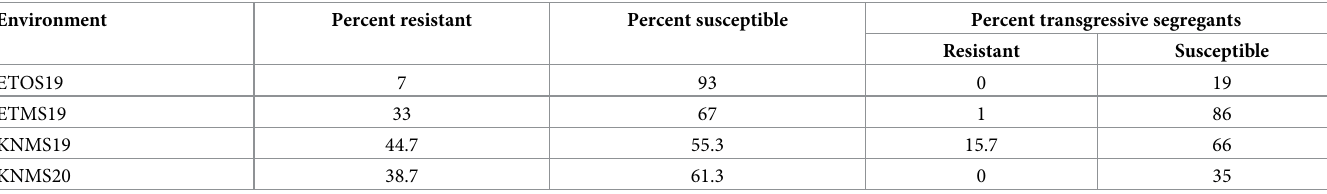
Table 3. Percentage of resistant, susceptible, and transgressive segregants of RILs evaluated for response to multiple stem rust races across four testing environments.